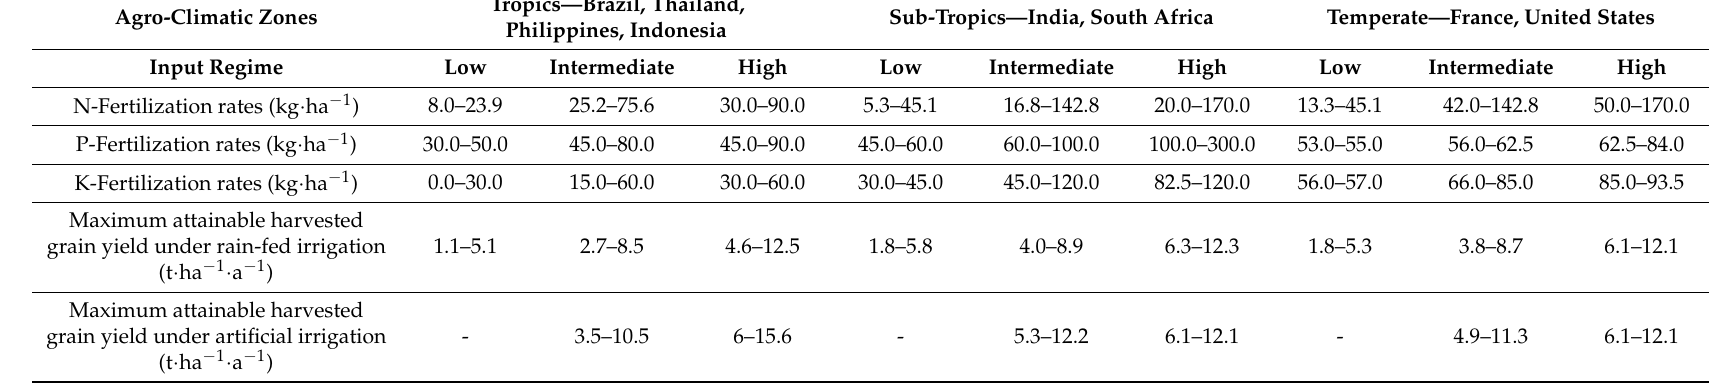
Table 2. Data on N, P and K fertilizer application rates and maximum attainable maize grain yields across three agro-climatic zones (tropics, sub-tropics and